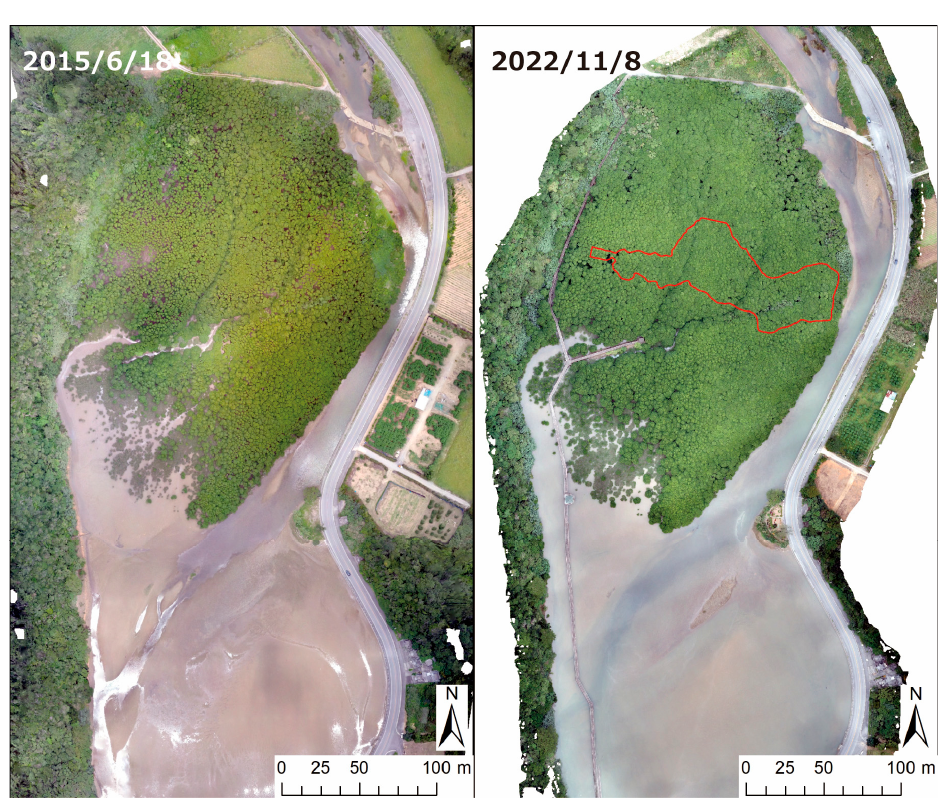
Figure 2. Changes in mangrove forests; comparison of orthomosaic images using UAVs. The red boundary is the validation area (4783 m 2 ).